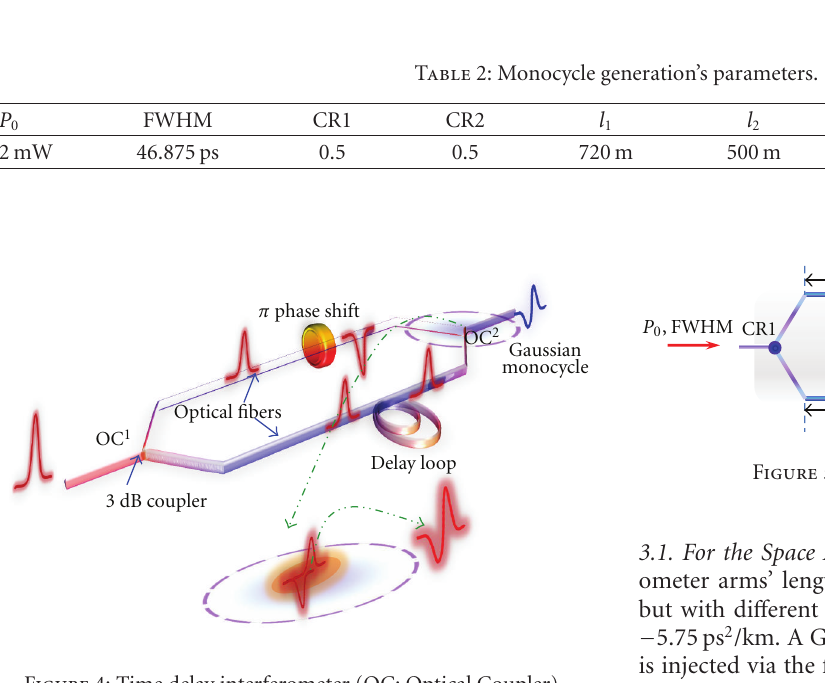
Figure 4: Time delay interferometer (OC: Optical Coupler).